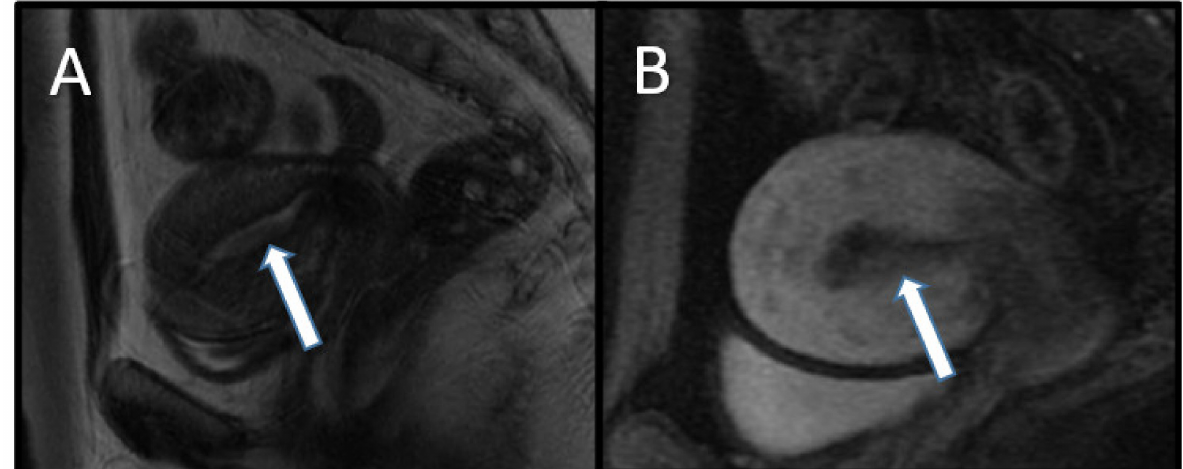
Figure 8. An 18-year-old woman with Cowden syndrome who underwent surveillance biopsy for dysmenorrhea and irregular menstrual bleeding. Biopsy-proven grade 1 endometrioid endometrial carcinoma was found, and staging magnetic resonance imaging (MRI) was performed. ( A ) Sagittal T2-weighted and ( B ) contrast-enhanced T1-weighted MR images show endometrial thickening (arrows) measuring approximately 2 cm. The patient subsequently underwent hysterectomy, and the pathologic diagnosis was upgraded to grade 2 endometrioid endometrial cancer.